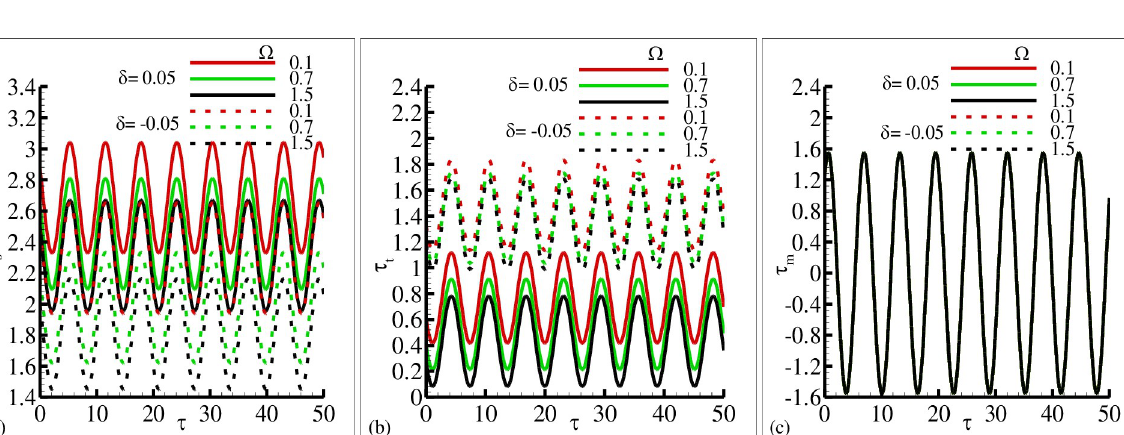
Fig 7. The graphical results of (a) τ parameters λ = 6.2, ξ = 0.2, Pr = 7.0, and O = 1.7.